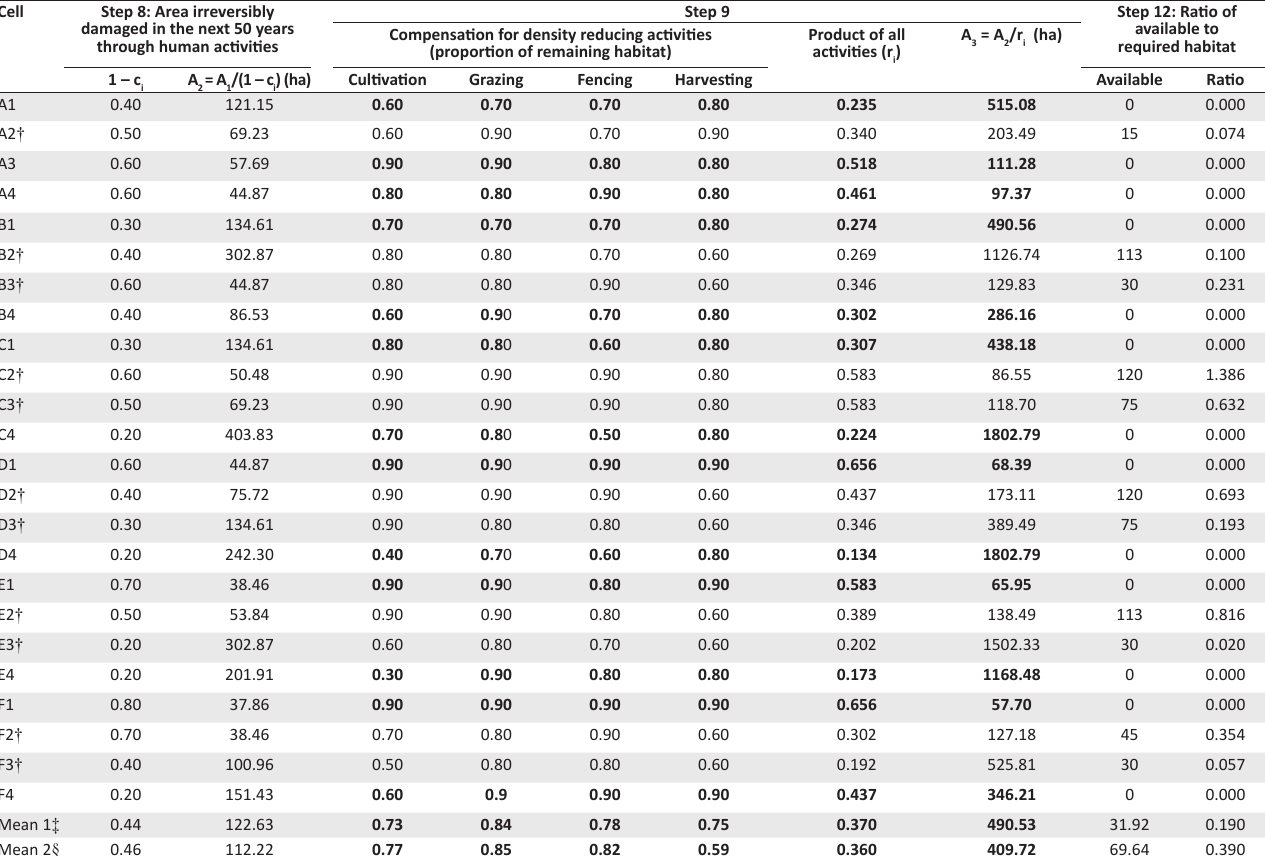
TABLE 2b: Brackenridgea zanguebarica minimum conservation area size using Burgman et al. ’s method (Steps 8, 9 and 12): Scenario 1 – Status quo conditions. Cell Step 8: Area irreversibly damaged in the next 50 years through human